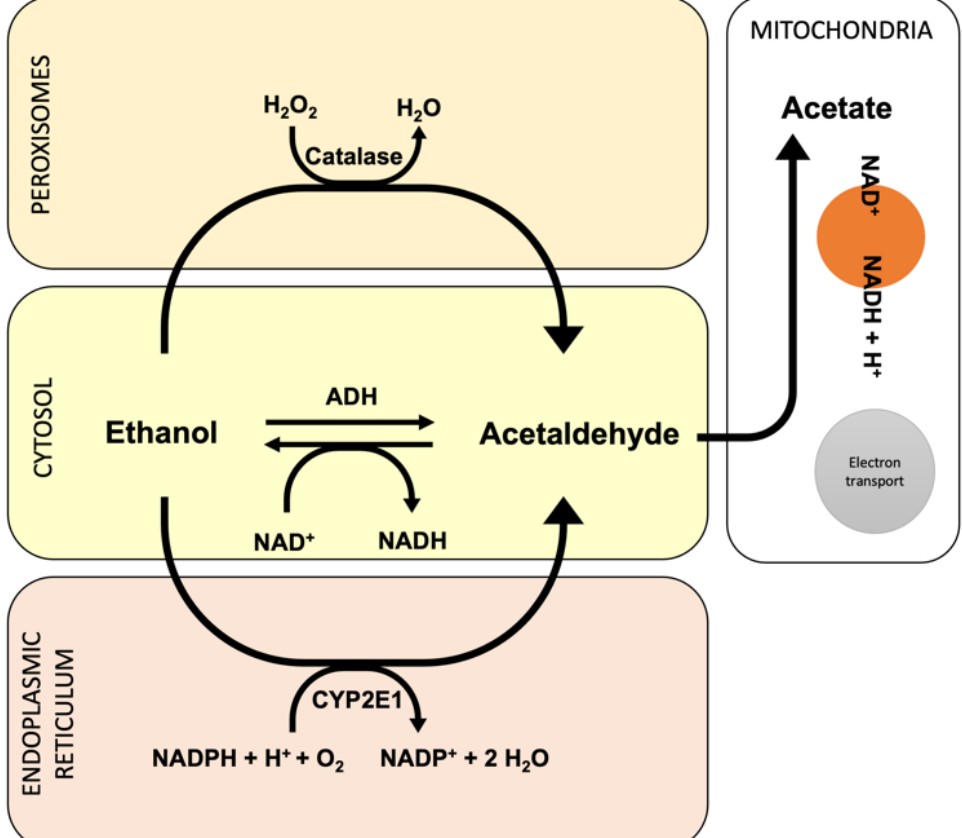
Figure 2. Oxidative pathway involved during ethanol metabolism .